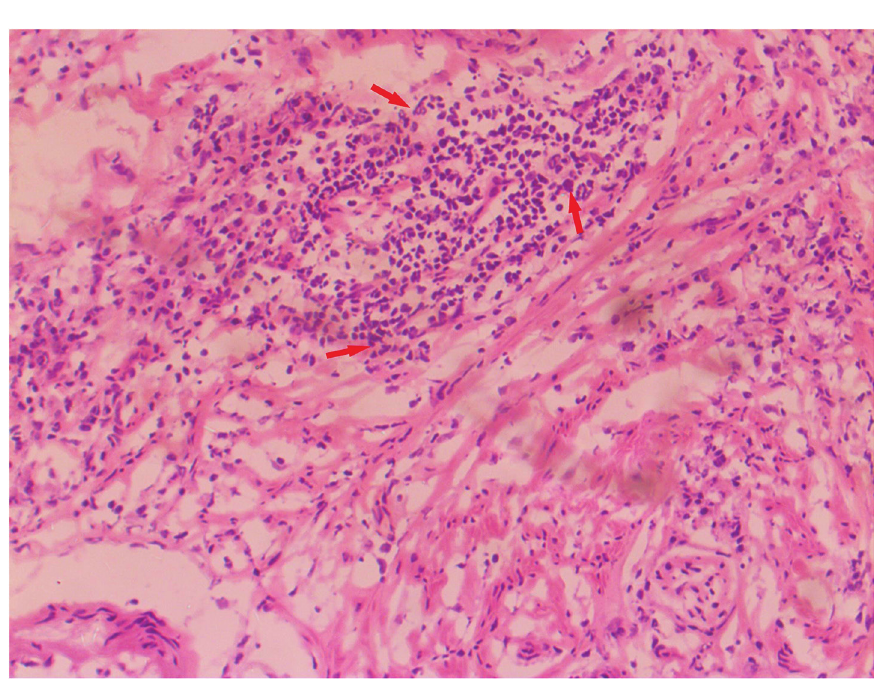
Figure 8. Histopathological examination showing the presence of a few inflammatory cells on the abscess